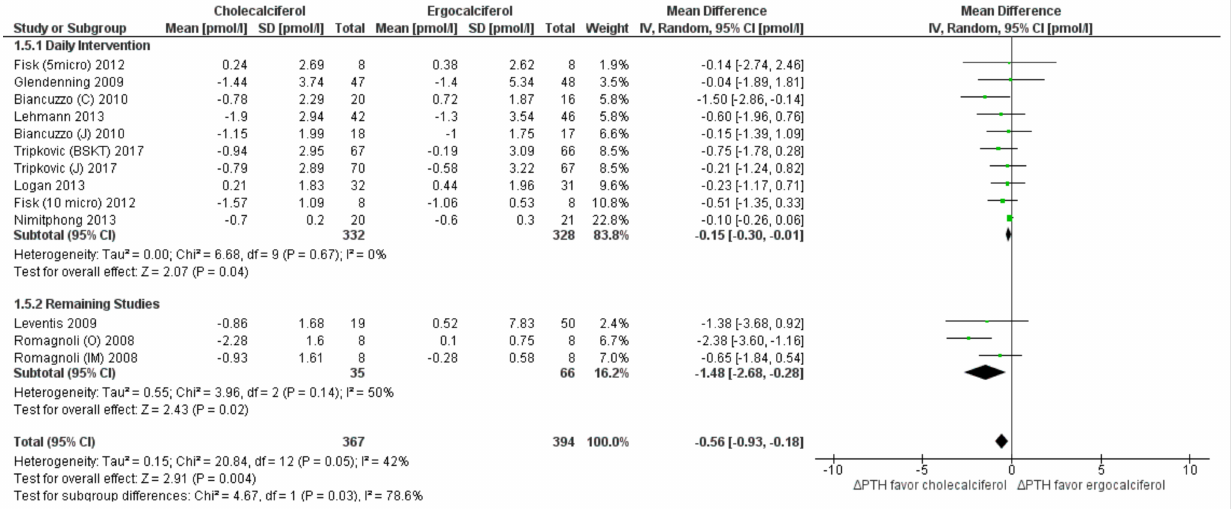
Figure 7. Forrest plot for parathyroid levels. Legend: Forrest plot of random effect meta-analysis comparing the effects of cholecalciferol vs. ergocalciferol supplementation on net changes in parathyroid (PTH) levels favored cholecalciferol. “ ∆ PTH” denotes the change in PTH concentrations from baseline (net change), squares denote the mean differences (with 95% confidence interval). The pooled results indicate a mean difference of 0.56 pmol/L (95% confidence interval 0.18–0.93 pmol/L), favoring cholecalciferol supplementation. Sub-group analyses in relation to dosage frequency (daily dosage vs. remaining studies) also demonstrated consistently higher PTH levels among the cholecalciferol-supplemented group as compared to the ergocalciferol group. However, the studies are moderately heterogeneous ( I 2 =